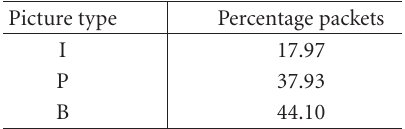
Table 3: Distribution of packets by picture type in the test video.